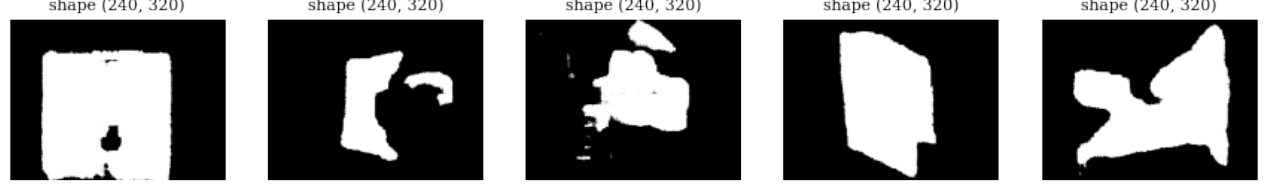
Figure 7. Evaluation with test data FCN Model.